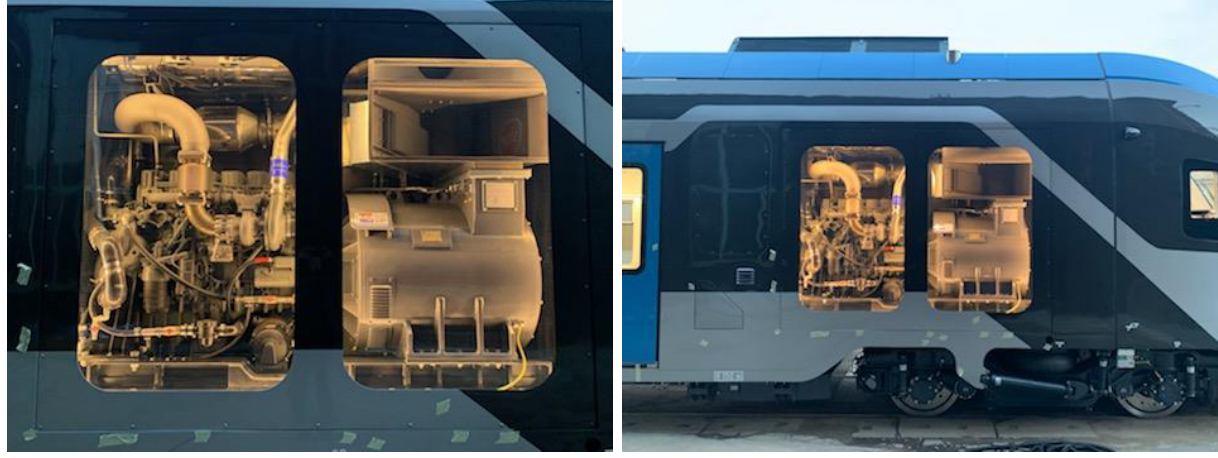
Fig. 17. Engine-generator unit of 227M railcar and 227M rail vehicle with drive